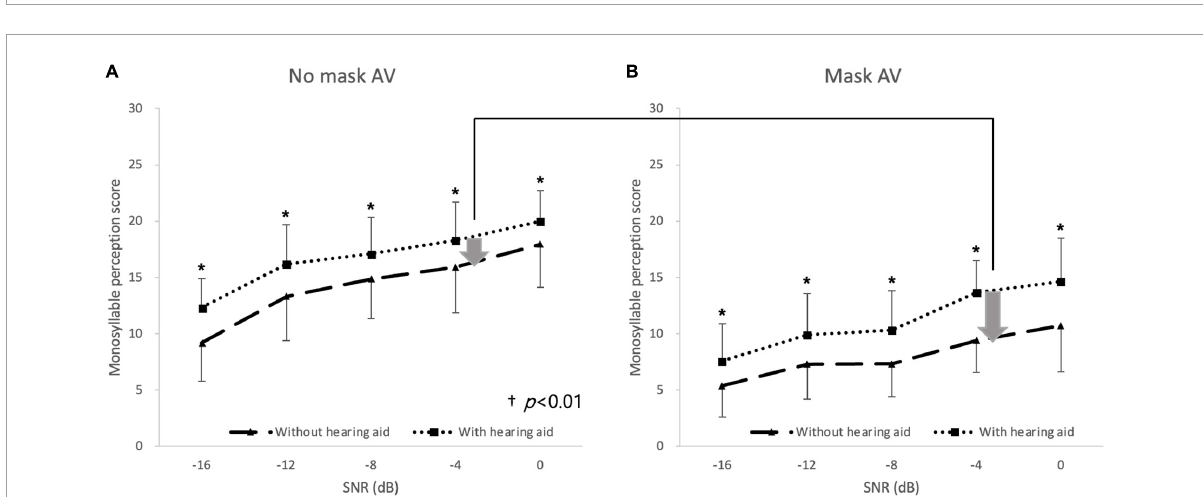
FIGURE5 Monosyllabic speech perception in noise with and without hearing aids. In the hearing-impaired group, speech perception was better with hearing aids than without hearing aid at all noise levels under (A) no-mask–auditory–verbal (AV) and (B) mask–AV conditions (* p < 0.003, Bonferroni’s corrected α = 0.05/15 = 0.003), and the difference in speech perception at –4 dB SNR depending on wearing hearing aids was greater under the mask–AV conditions than under the no-mask–AV conditions ( † p < 0.01, Bonferroni’s corrected α = 0.05/5 =